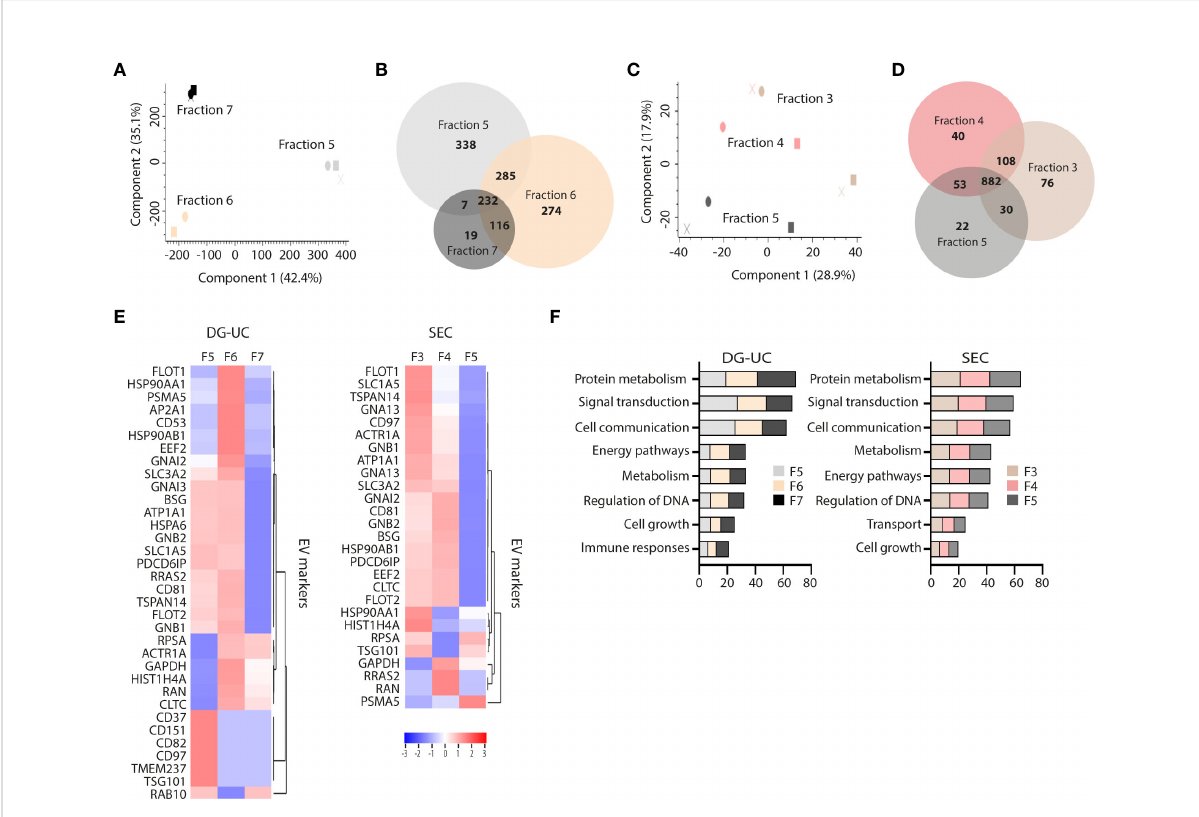
FIGURE 3 Comparative proteomic pro fi ling of NK-EV subpopulations generated by DG-UC or SEC. (A) PCA analysis and (B) Venn diagram depicting differences in protein pro fi les between DG-UC fractions 5-7. (C) PCA analysis and (D) Venn diagram depicting differences in protein pro fi les between SEC fractions 3-5. (E) Heatmaps of EV markers in DG-UC fractions 5-7 or SEC fractions 3-5 represented by log2 mean intensity values of three biological replicates. (F) FunRich biological pathway analysis of proteins identi fi ed DG-UC fractions 5-7 or SEC fractions 3-5, showing percentage enrichment of